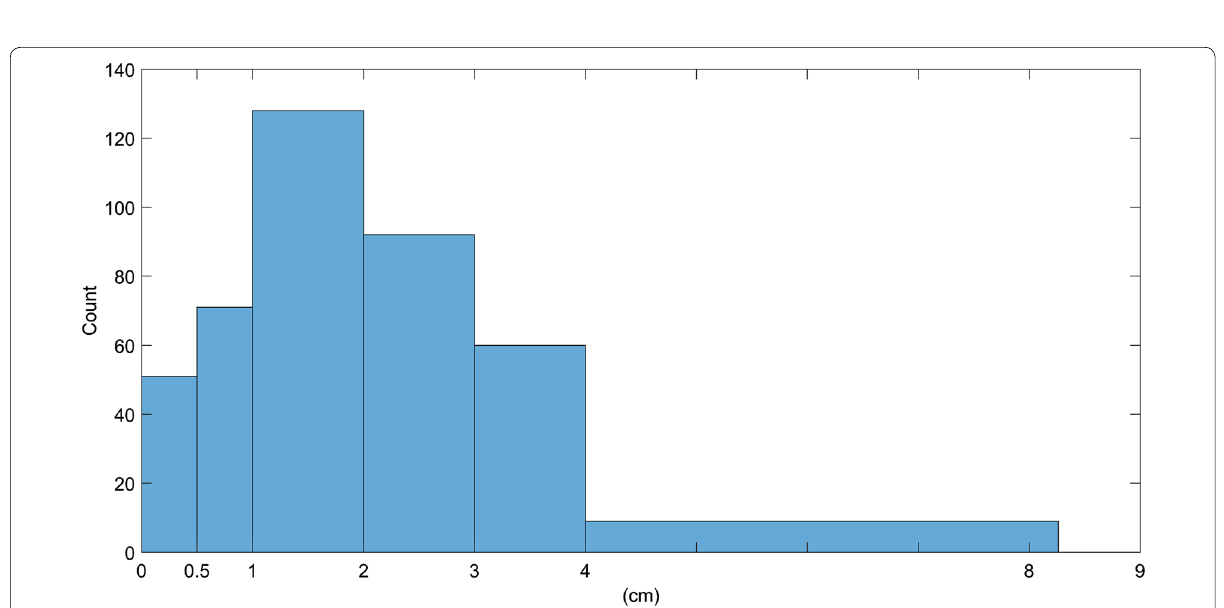
Fig. 9 Histogram of slant delay difference at 3° elevation angle for the GPS DDA